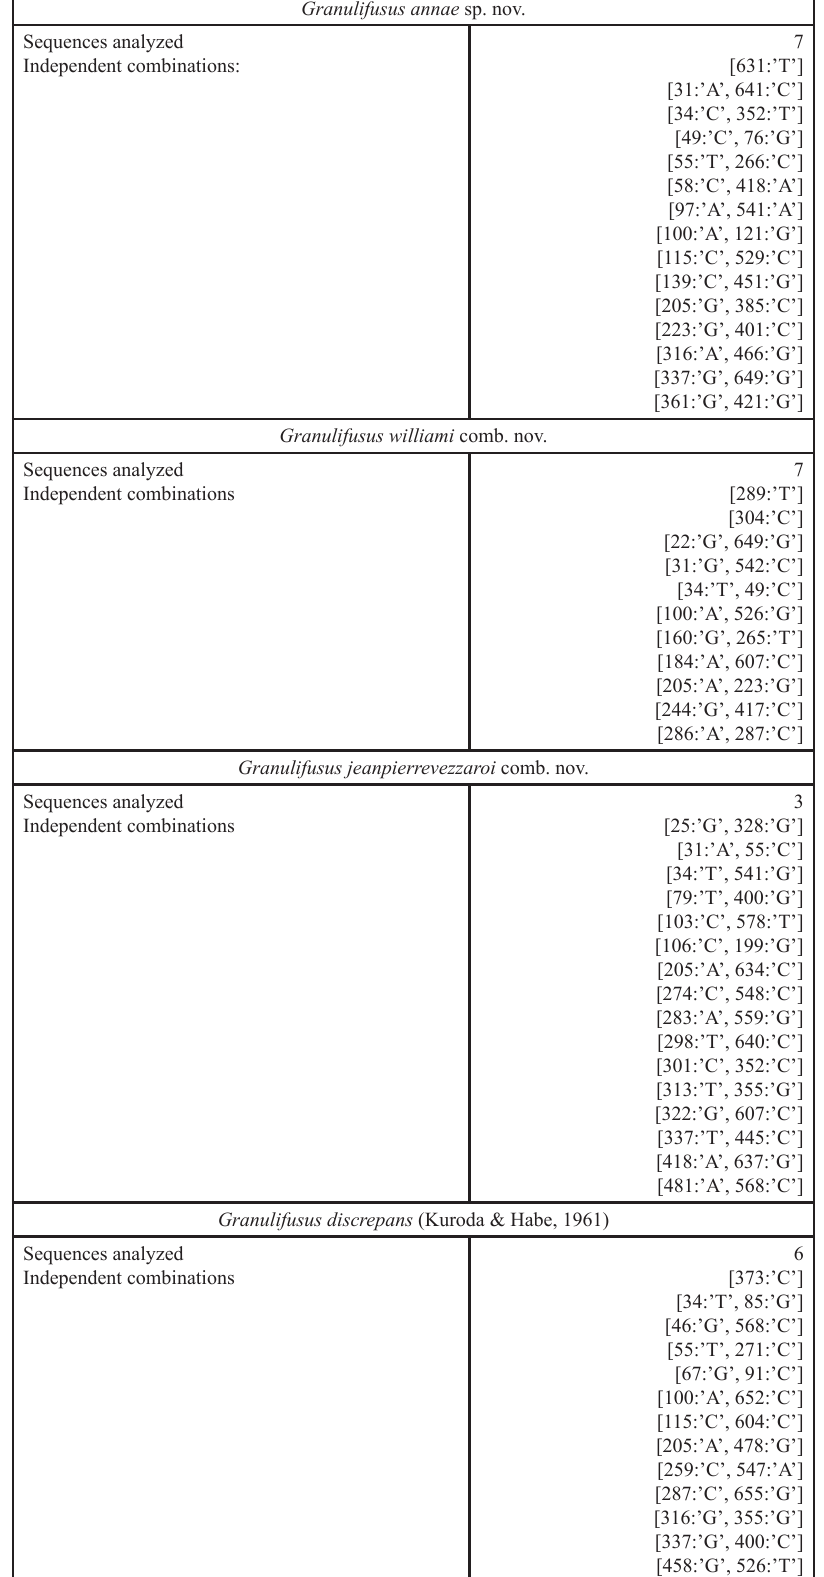
Table 2. Molecular diagnostic characters of species of Vermeijius gen.